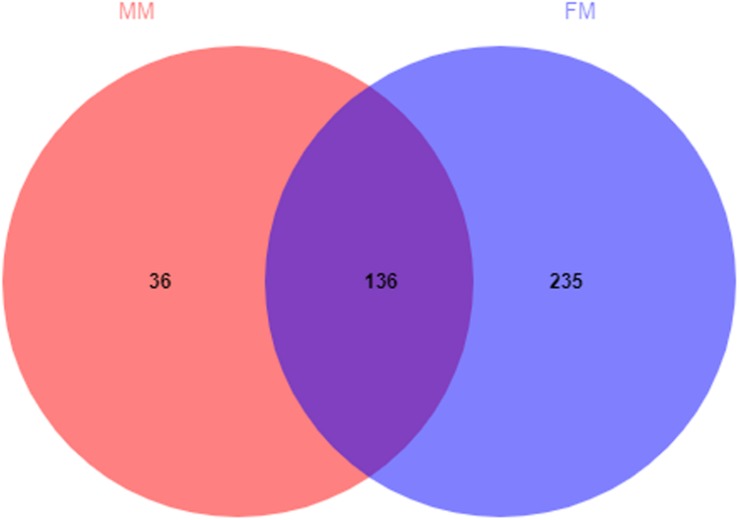
Venn diagram of OTUs in the female and the male swamp eels. The numbers of shared and unique OTUs are displayed.